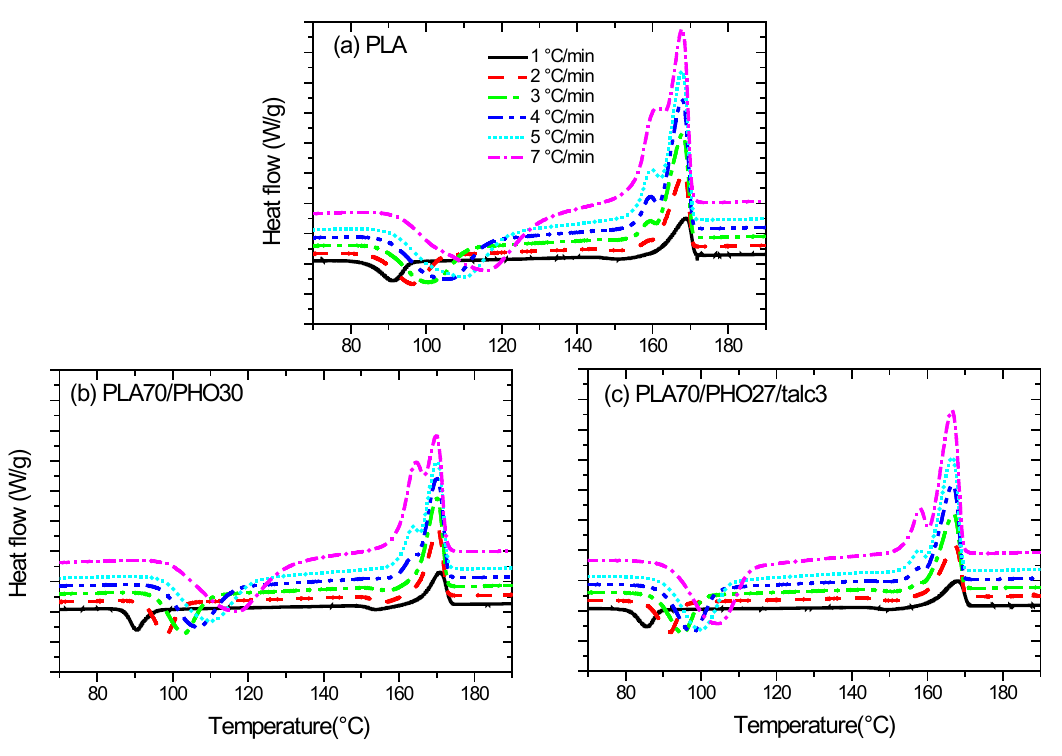
Figure 2: DSC thermograms of nonisothermal cold crystallization for neat PLA and its